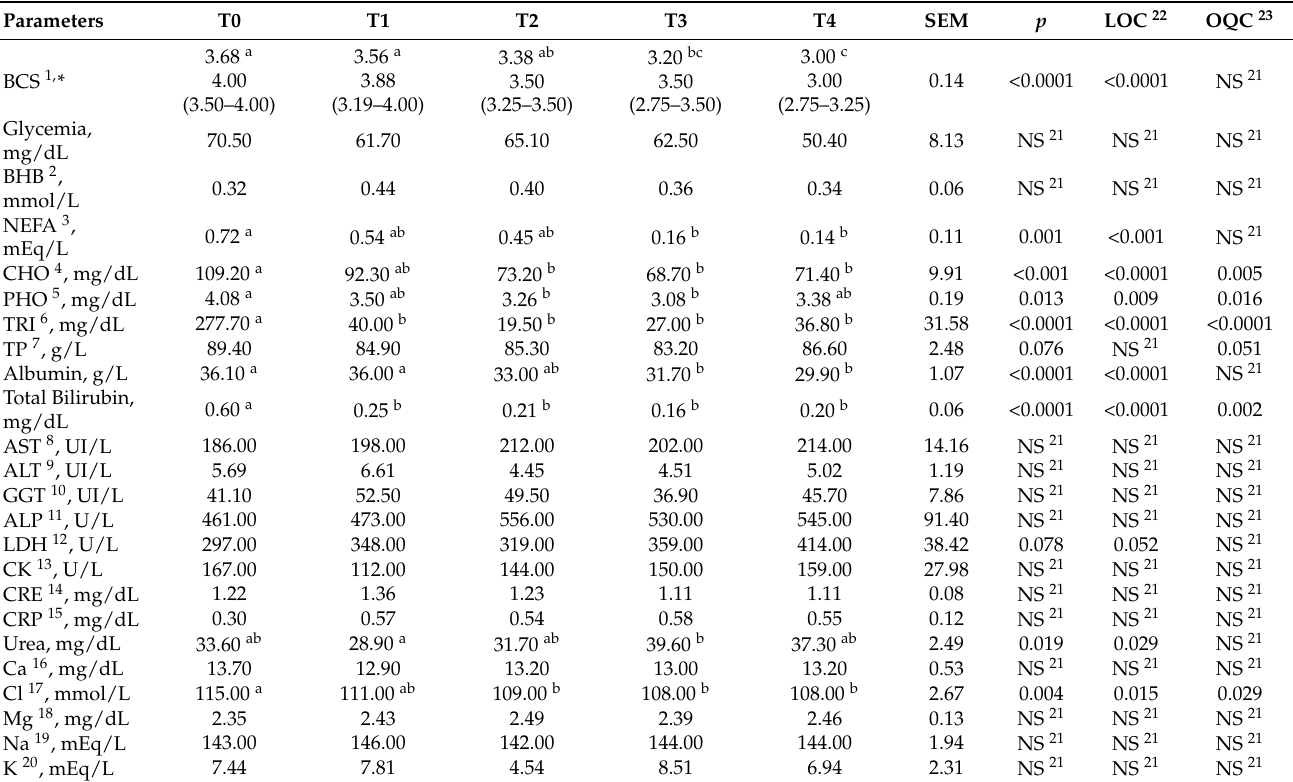
Table 1. Least square means and standard error of the mean (SEM) of BCS and biochemical parameters from pre-foaling (T0: 15 days before foaling) to post-foaling (T1: 15, T2: 30, T3: 60, T4: 90 days after foaling) of